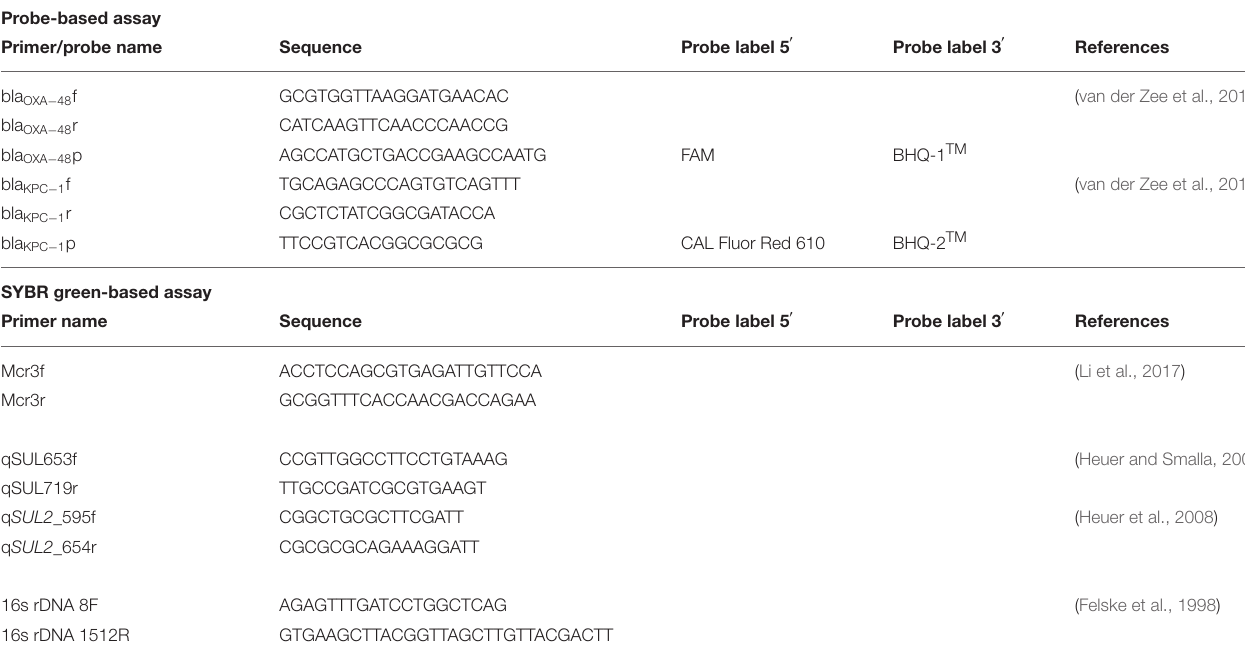
TABLE 1 | Sequences and references of primers and probes used in both probe-based and SYBR Green-based qPCR assays. Probe-based